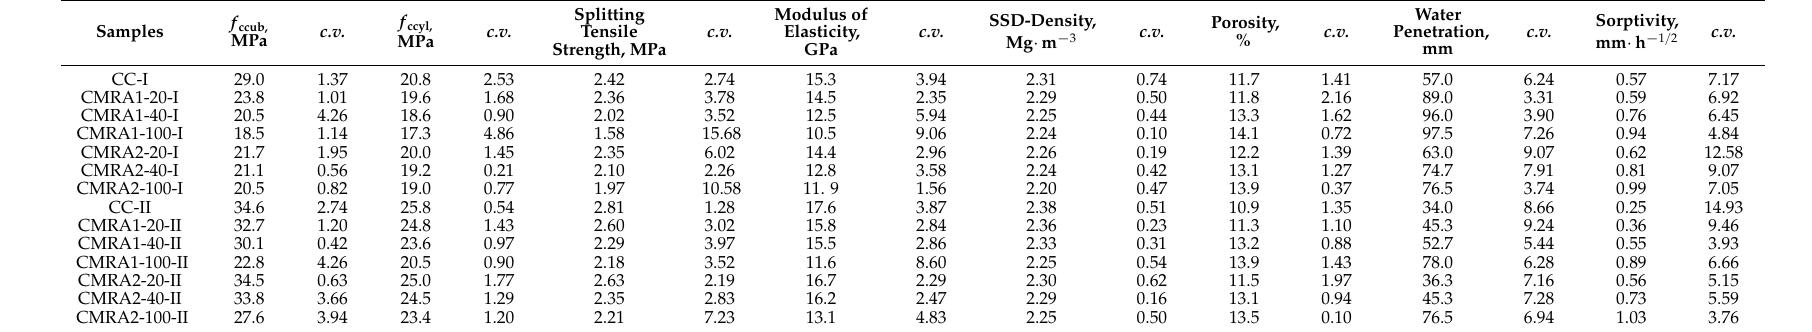
Table 7. Means values of the results of all